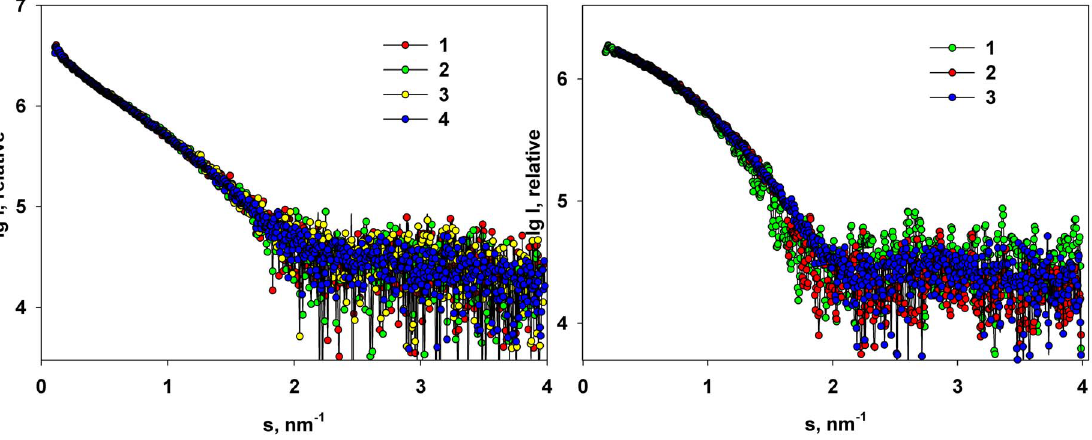
Figure 2. Experimental SAXS patterns from the full length M1 protein (left panel) and the NM-domain (right panel). The individual curves correspond to the varying solute concentrations; for M1, curves 1 to 4 represent c= 4.5 mg/ml; 3.4 mg/ml, 2.3 mg/ml and 1.7 mg/ml, respectively; for NM-domain, curves 1 to 3 represent c=3.8 mg/ml, 3.0 mg/ml and 1.5 mg/ml, respectively.